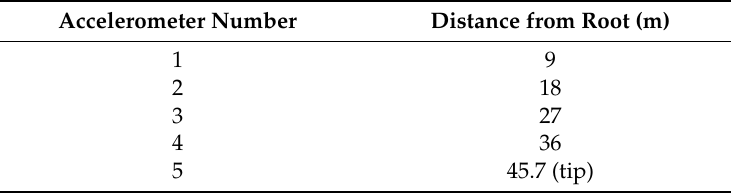
Table 2. Accelerometers